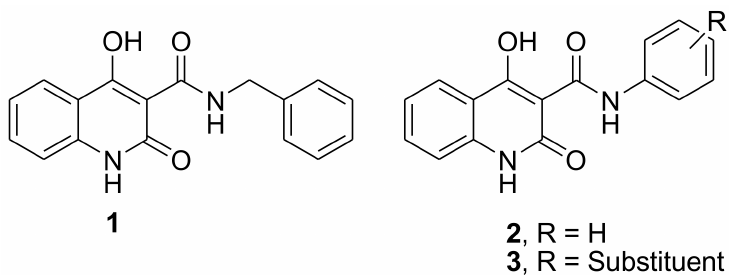
Figure 1. Chemical structures of 1, 2 , and 3 .